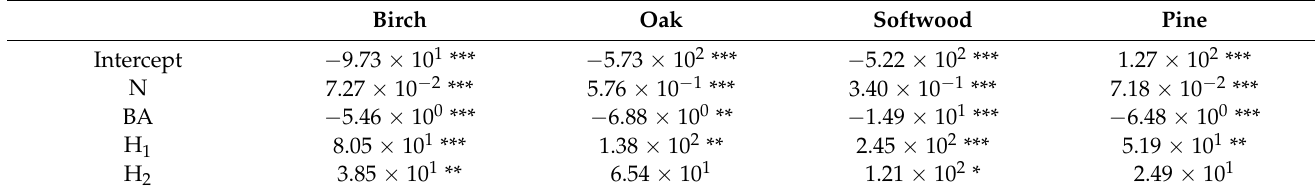
Table A2. The estimated parameters with the lack-of-fit statistics for the recruitment model of NCM. The dependent variable, recruitment, was derived in units of trees per hectare every five years. Birch